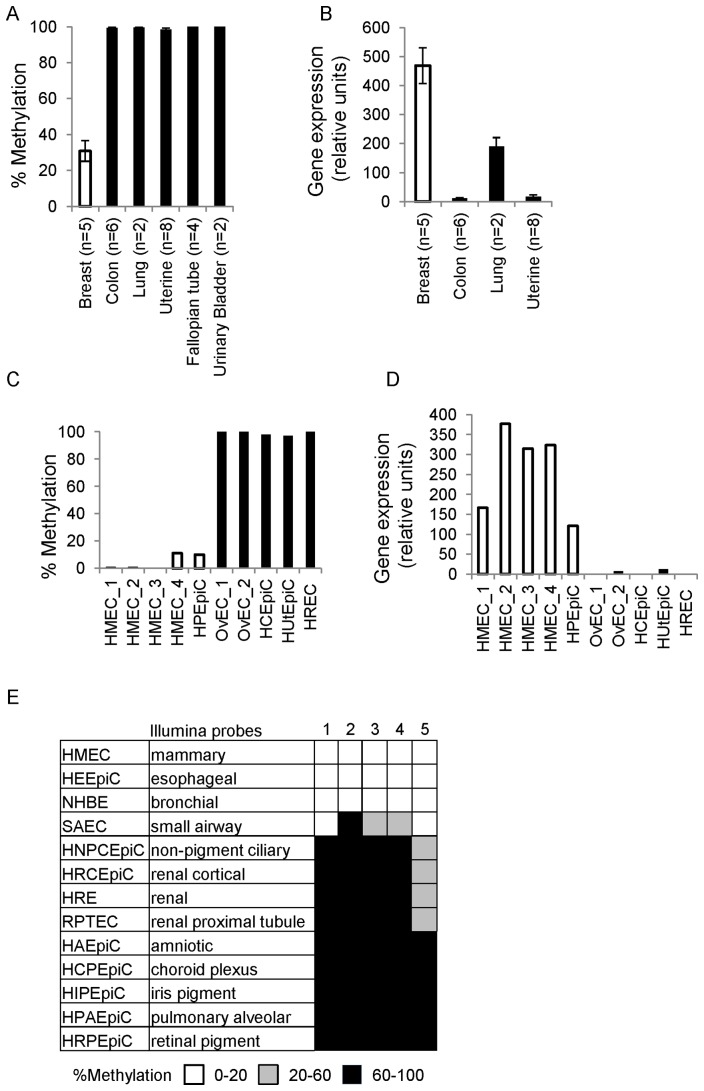
TRIM29 promoter methylation and gene expression varies in normal epithelial tissues.(A&C) Q-MSP at TRIM29 promoter in (A) various human normal tissues enriched for epithelium and (C) purified human normal epithelial cells. The same tissue samples studied by the Illumina methylation array were included in (A). Q-MSP amplicon overlapped with the sequence of Illumina probe #cg13625403 used for array analysis (Table S4). (B&D) The same samples were used for gene expression analysis by qRT-PCR that showed inverse correlation with promoter methylation (RNA was not available for fallopian tube and urinary bladder). HMEC- human mammary epithelial cells, HPEpiC-prostate, OvEC-ovarian, HCEpiC- colon, HUtEpiC-uterine, HREC-renal. (E) Data from Illumina Infinium methylation450K array obtained from ENCODE showed similar pattern of TRIM29 promoter methylation in additional purified human normal epithelial cells. Methylation at 5 Illumina probes is shown: 1.cg20655548 2.cg12201660 3.cg17971587 4.cg13285004 5.cg13625403 (Table S4B). Each row refers to one individual.